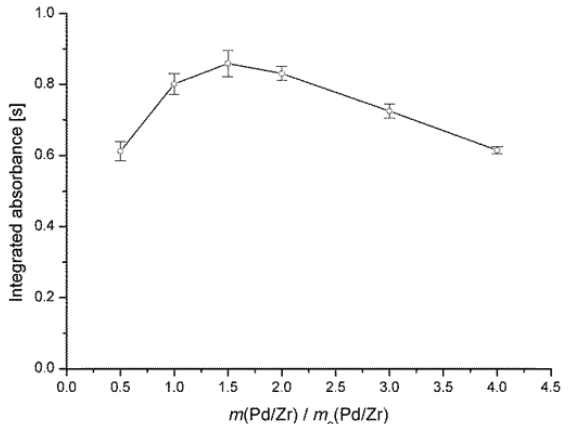
Figure 2. Dependence of GaF molecule absorbance at 211.248 nm on the relative mass of palla- dium/zirconium modifier used for furnace pretreatment; T pyrol. = 600 °C; T vapor. = 1540 °C; m o (Pd) = 5.0 μ g; m o (Zr) = 0.1 μ g [2]; m (Ru) = 3.0 μ g; C (Ga pretr. ) = 50 μ g; m (Ga sol. ) = 20 μ g; m (CH 3 COONa) = 5.0 μ g.